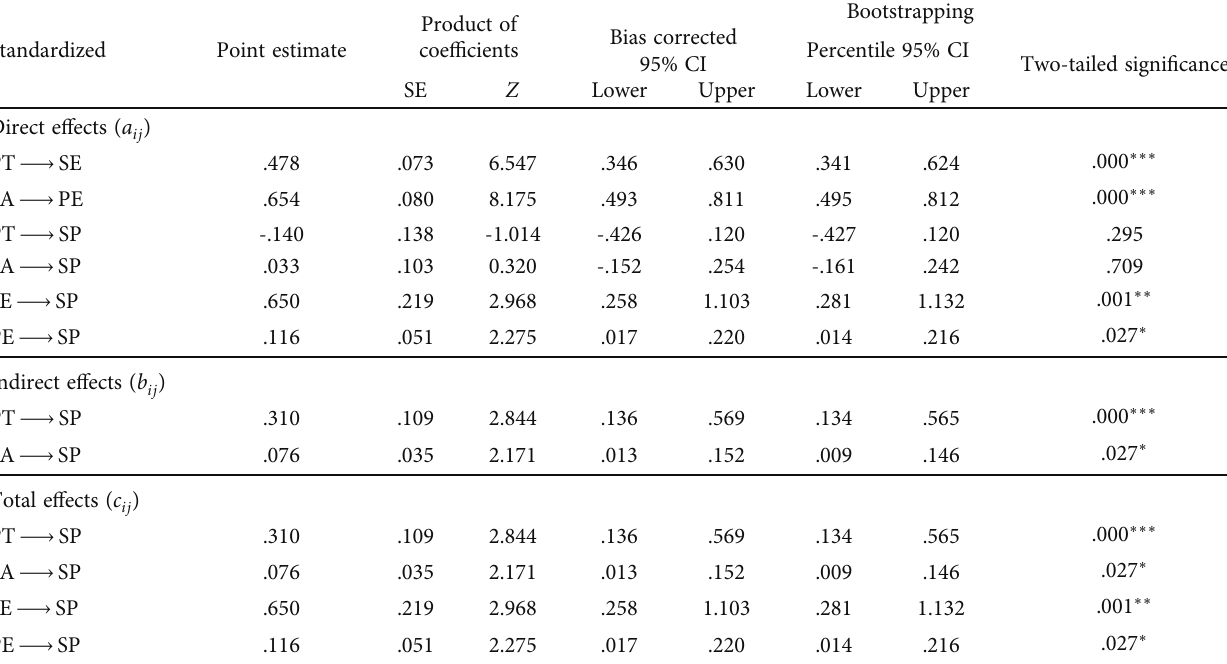
Figure 4: Standardized path coe ffi cient for the structural model (note: ∗∗∗ p < 0 : 001 and ∗∗ p < 0 : 01 ). Table 6: Standardized direct, indirect, and total e ff